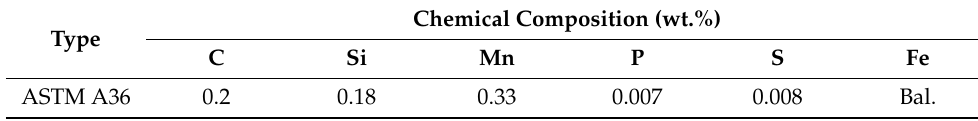
Table 2. Chemical composition of ASTM A36